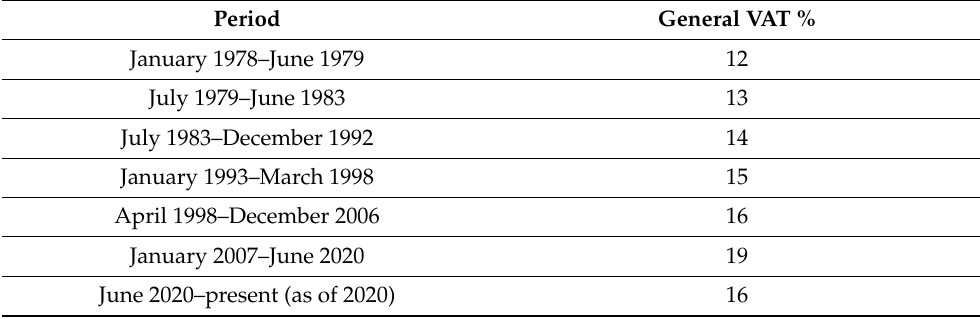
Table 2. VAT of Germany, 1978 to 2020.